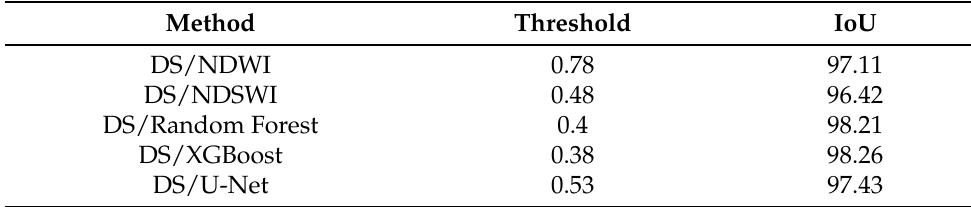
Table 1. Threshold selection using exhaustive search